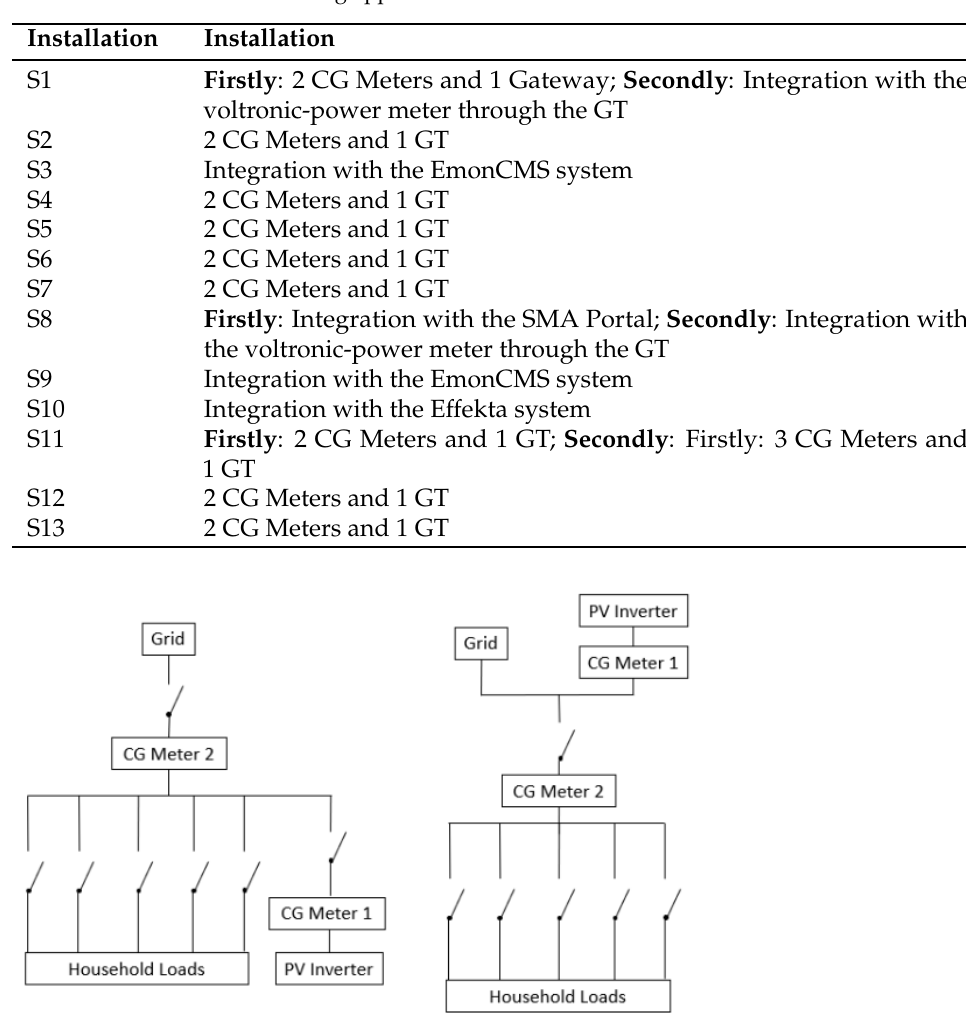
Table 1. Installation and metering approach for each site.